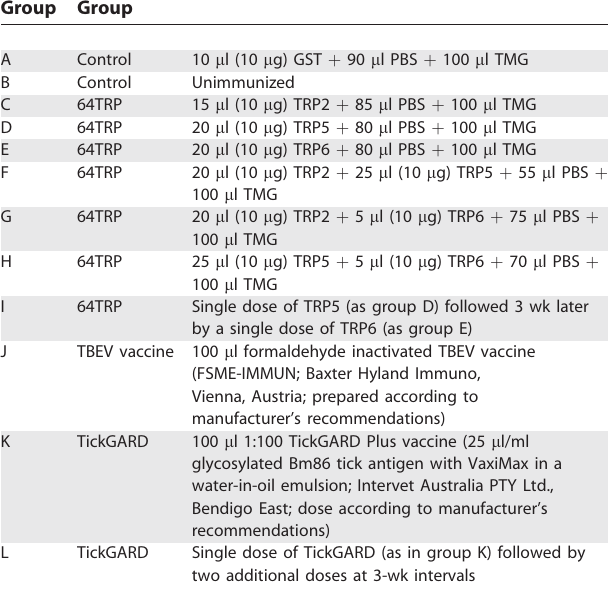
Table 2. Immunization Regimes Mouse Treatment Treatment per Mouse Group Group A Control